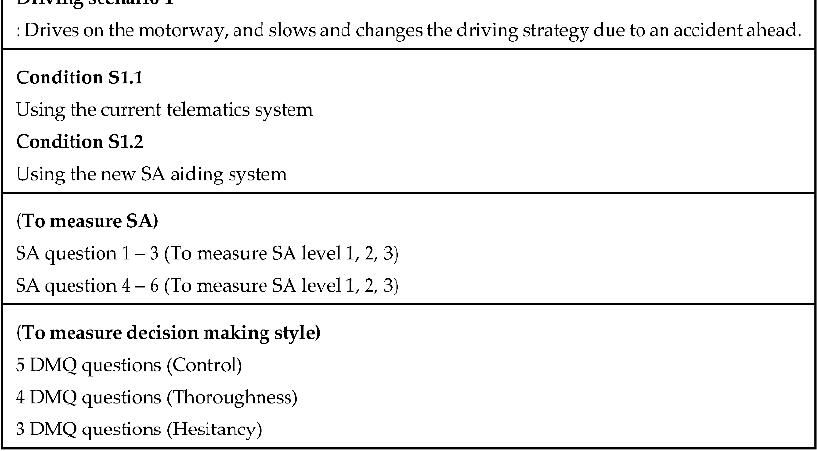
Figure 3. Descriptions of the first driving scenario (Source: Own creation). Sensors 2020 , 20 , x